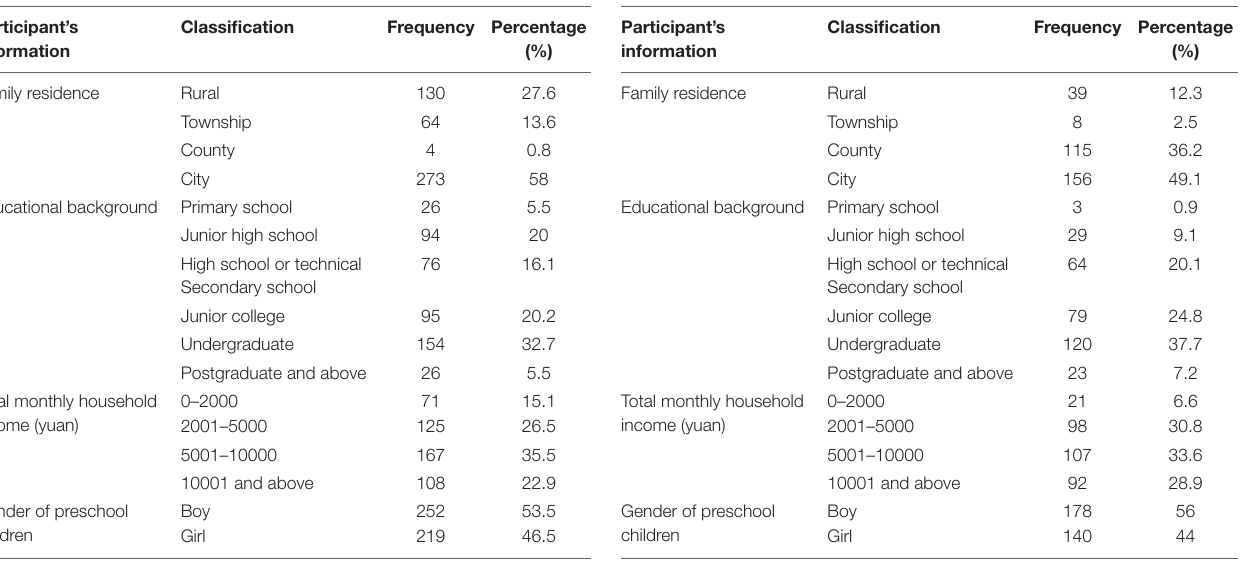
TABLE 4 | Basic participant information of Sample 2 in Study 4 ( n =